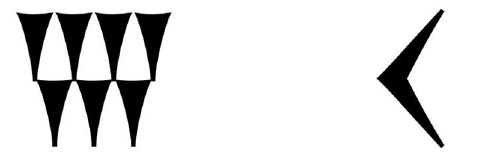
Figure 2. The cuneiform signs for the Number 7 (left) and the Number 10